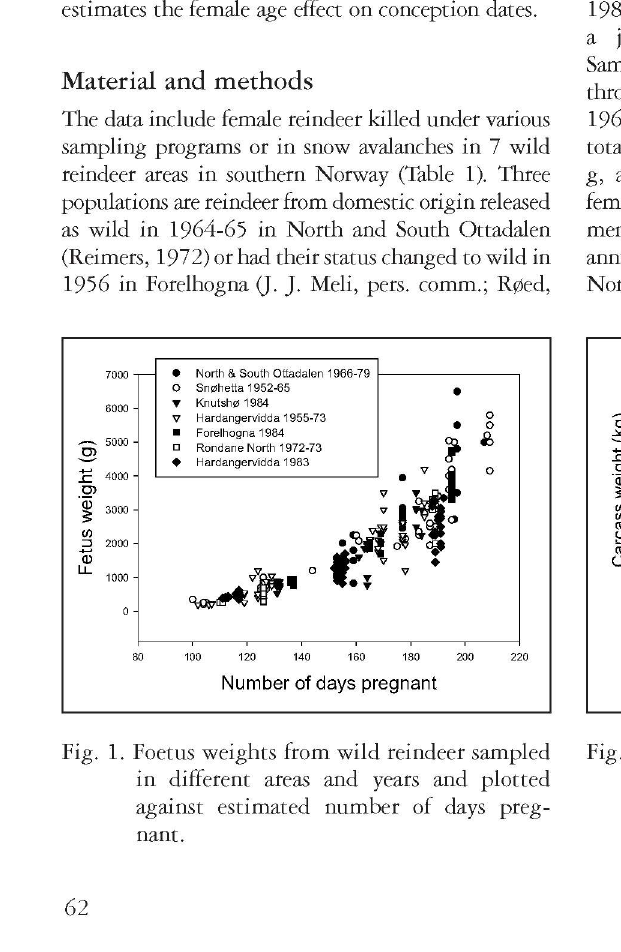
Fig. 2. Female carcass weights (from Table 1) +95% confidence intervals (CI) and regression esti¬ mated ln foetus weights ±95% CI at age 130 days. Foetus weights are calculated on basis of regression equations in Table